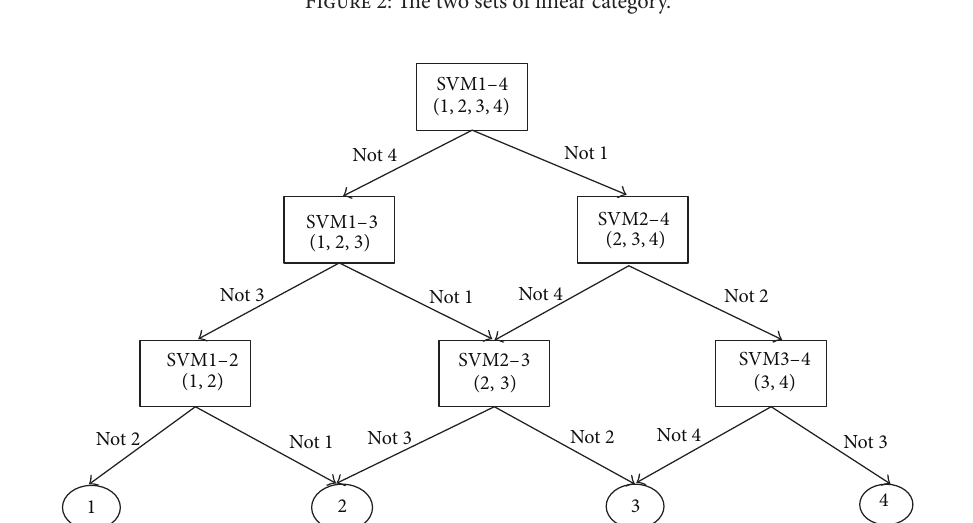
Figure 3: Directed acyclic graph SVM method.